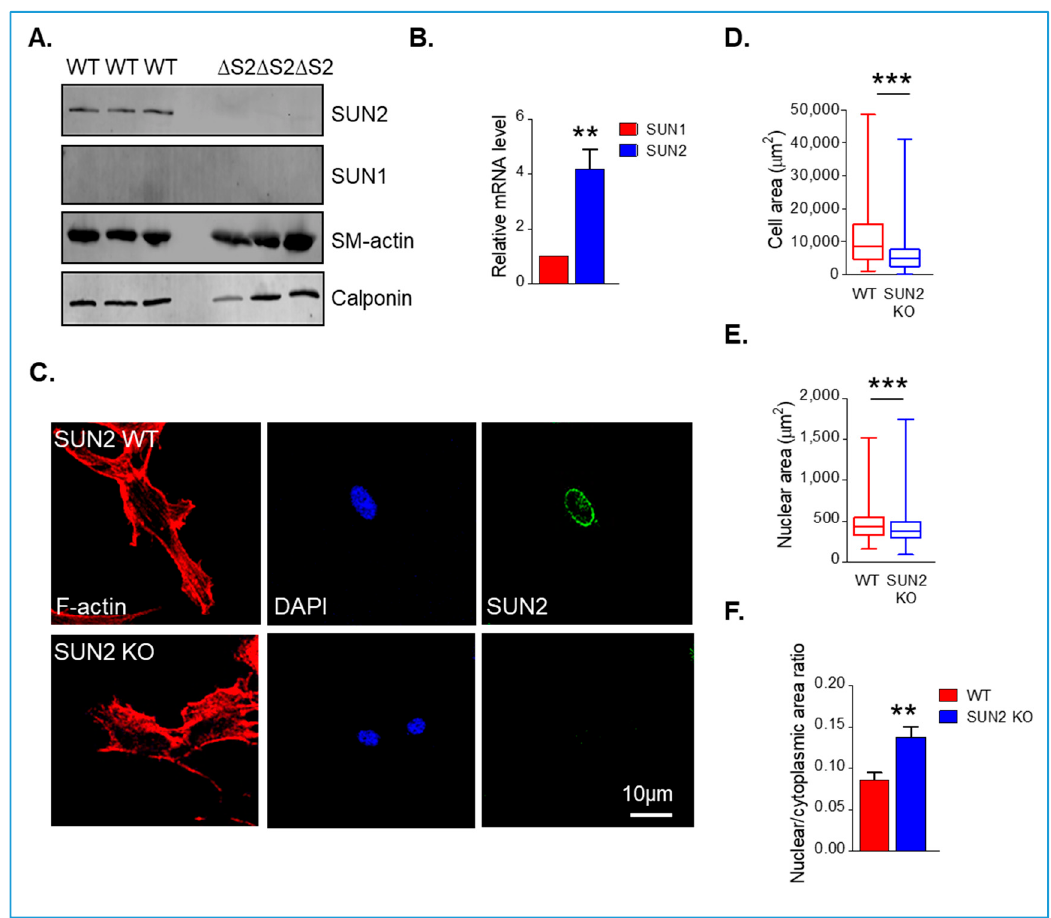
Figure 3. SUN2 KO VSMCs display reduced spreading. ( A ) WB of wild-type (WT) and SUN2 KO aortic samples. Each lane corresponds to an independent aortic sample isolated from different WT and SUN2 KO mice. ( B ) qPCR analysis of SUN1 and SUN2 mRNA expression in WT aortae. ( C ) Representative images of isolated WT and SUN2 KO mouse aortic VSMCs stained for F-actin (red), SUN2 (green), and DAPI (blue). Graphs show ( D ) cell area, ( E ) nuclear area, and ( F ) nuclear area:cell area ratio of WT and SUN2 KO VSMCs. Graphs represent the combined data of three independent experiments analysing >200 cells per group (** p < 0.01 and *** p < 0.0001).